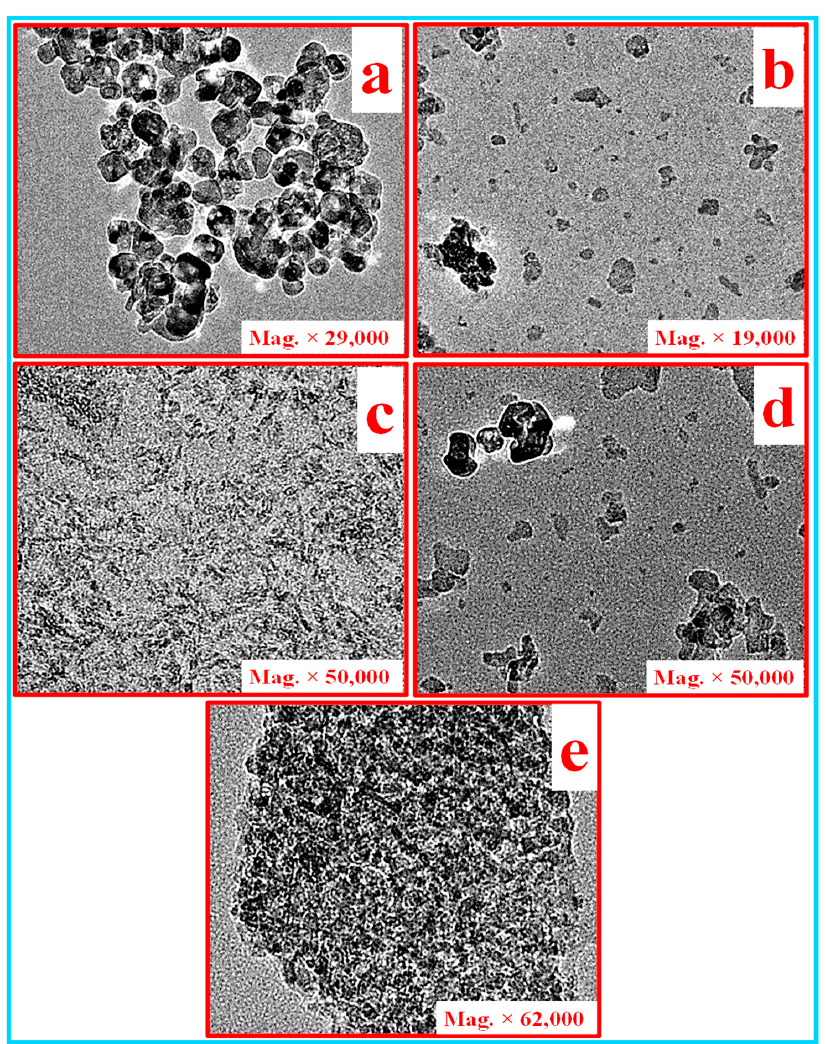
/ TiO / CNC 2 and ( e ) Al 2 O 3